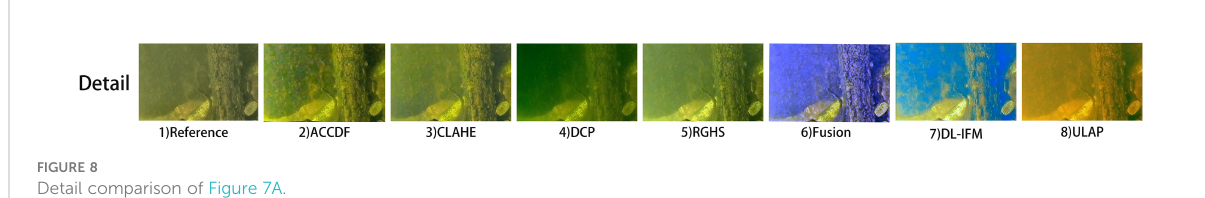
FIGURE 8 Detail comparison of Figure 7A.